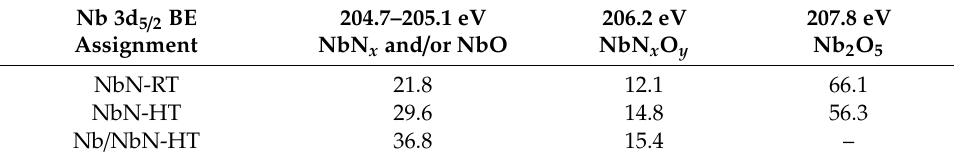
Figure 6. XPS curve-fitting of N 3d, N 1s, and O 1s spectra in the investigated samples. Table 5. XPS curve-fitting results of Nb 3d spectra (total peak area = 100%).